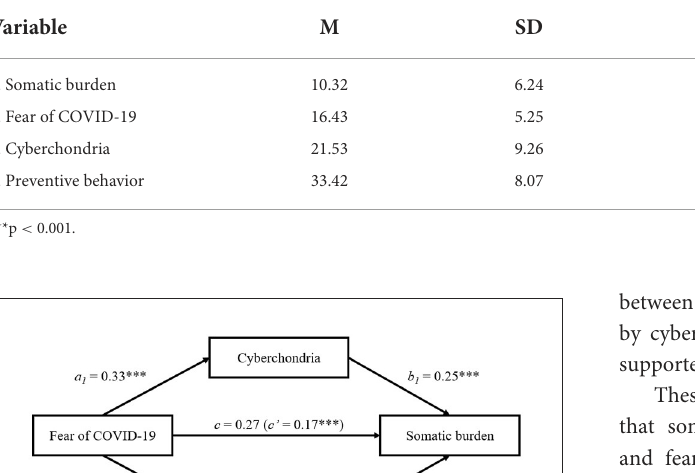
TABLE 1 Descriptive statistics and correlation matrix.